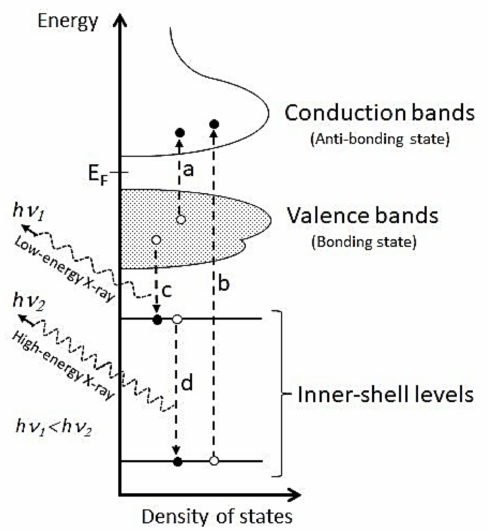
Figure 1. Electronic transitions related to electron energy-loss spectroscopy, a and b, and X-ray emission spectroscopy, c and d. Only X-ray emissions due to transitions c include a chemical bonding